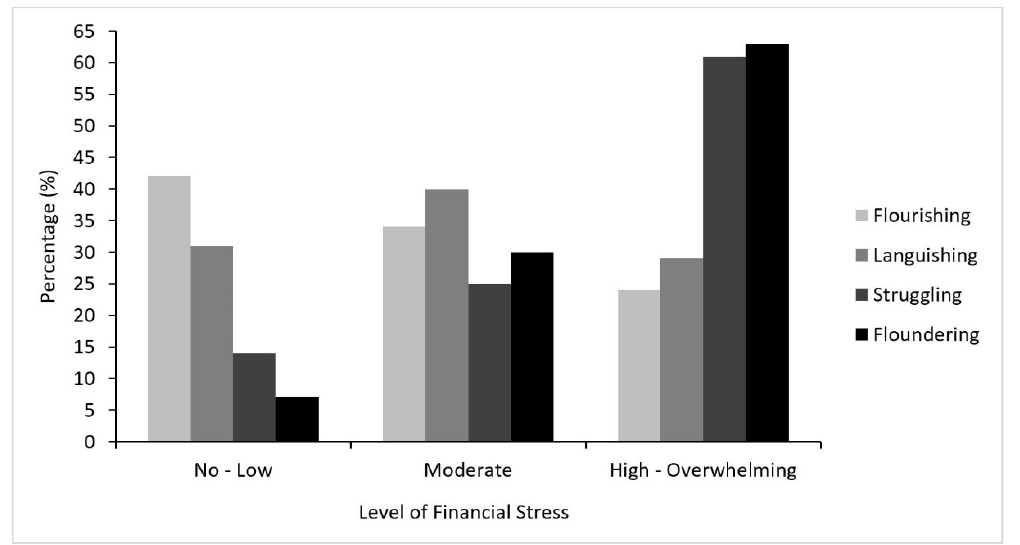
Figure 3. Financial stress by mental health state during the COVID-19 pandemic.